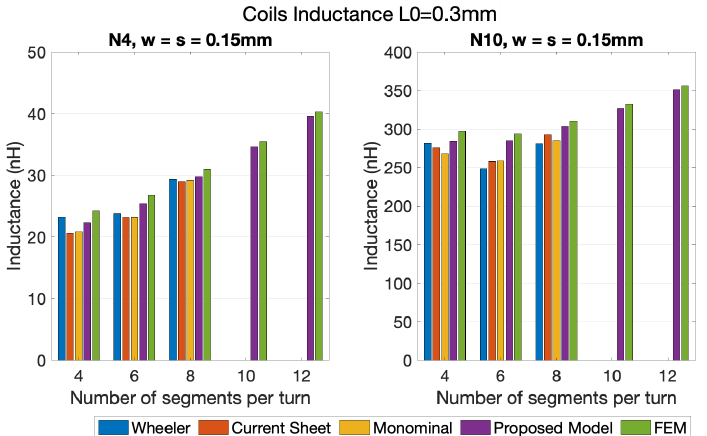
Figure 10. Comparison between several methods of inductance calculation of coils with 4 and 10 turns, for L 0 = 0.3 mm, w = s = 0.10 mm, and for 4, 6, 8, 10, and 12 segments per turn.